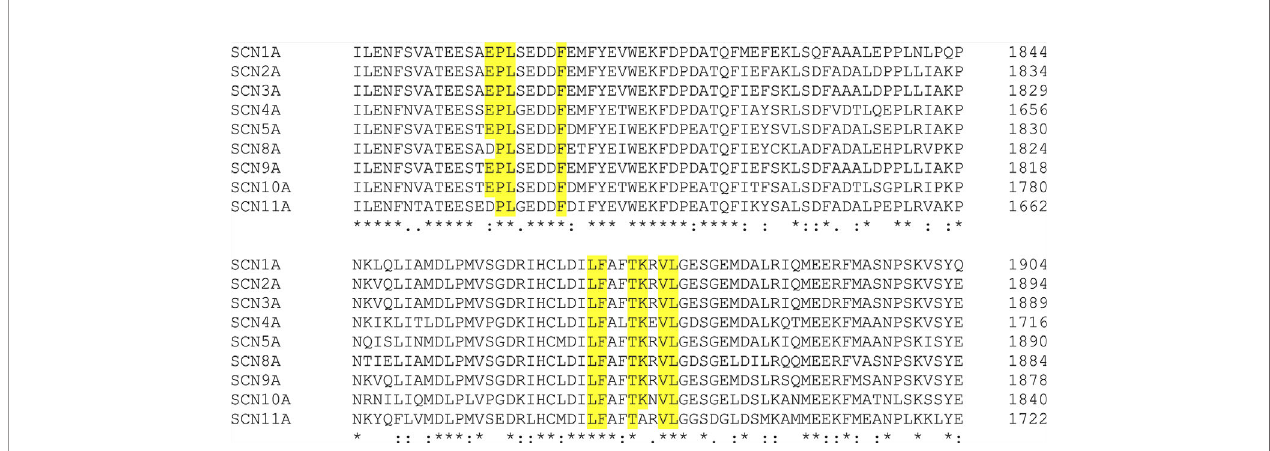
FIGURE 7 | Clustal alignment of amino acid sequences of Na v 1.1-Na v 1.9 ( SCN1A-SCN11A ). ESL was proposed previously (Shaikh et al., 2014) to interact with the highlighted amino acids in Na v 1.2. An alignment of Na v 1.2 [UniProtKB - Q99250 (SCN2A_HUMAN)] with Na v 1.1 [UniProtKB - P35498 (SCN1A_HUMAN)], Na v 1.3 [UniProtKB - Q9NY46 (SCN3A_HUMAN)], Na v 1.4 [UniProtKB - P35499 (SCN4A_HUMAN)], Na v 1.5 [UniProtKB - Q14524 (SCN5A_HUMAN)] Na v 1.6 [UniProtKB - Q9UQD0 (SCN8A_HUMAN)], Na v 1.7 [UniProtKB - Q15858 (SCN9A_HUMAN)], Na v 1.8 [UniProtKB - Q9Y5Y9 (SCN10A_HUMAN)], and Na v 1.9 [UniProtKB - Q9UI33 (SCN11A_HUMAN)] shows that the interacting amino acids highlighted in yellow are conserved between Na v 1.2 and Na v 1.5, along with most other isoforms. Asterisks indicate conserved residues. Colon indicates conservation between groups of strongly similar properties - scoring >0.5 in the Gonnet PAM 250 matrix. Period indicates conservation between groups of weakly similar properties - scoring ≤ 0.5 in the Gonnet PAM 250